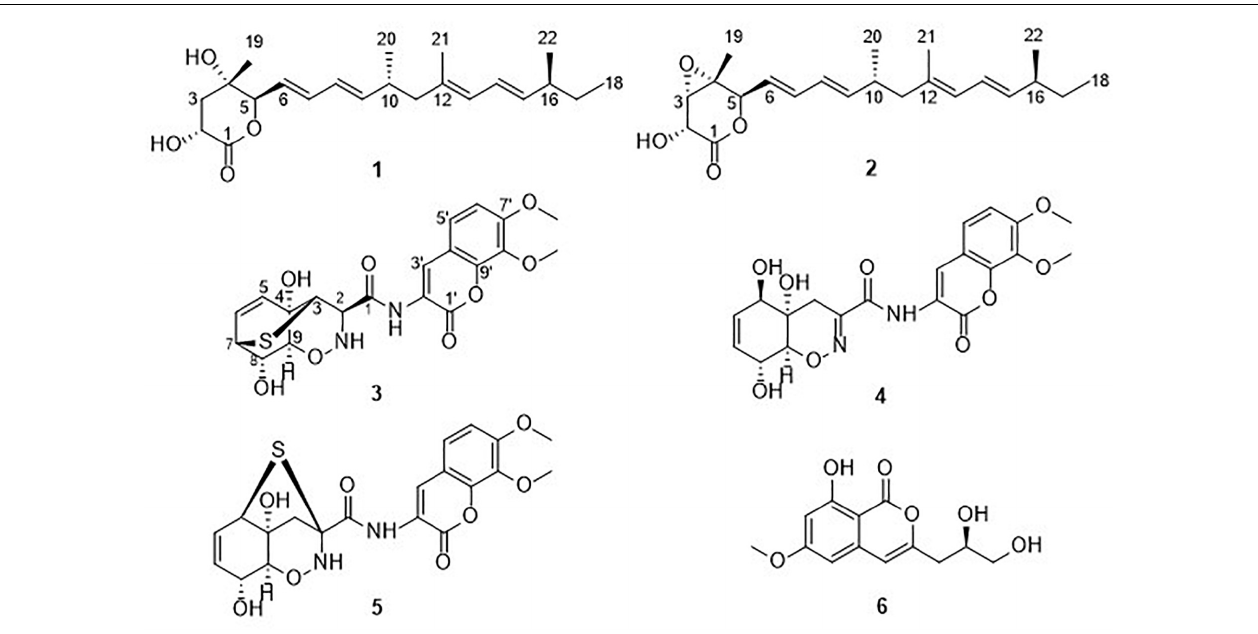
FIGURE 1 | Chemical structures of compounds 1–6